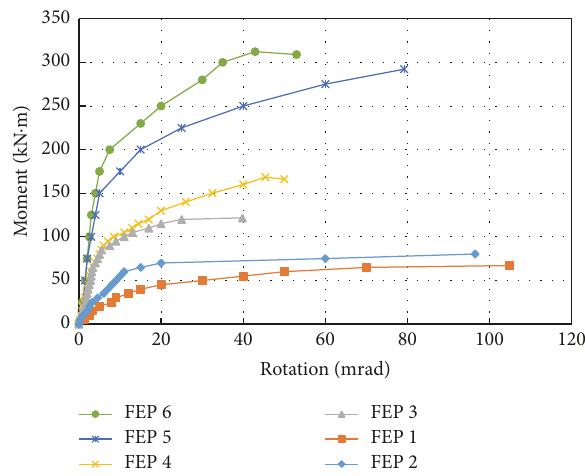
Figure 8: Moment-rotation curves of flush end-plate connections.